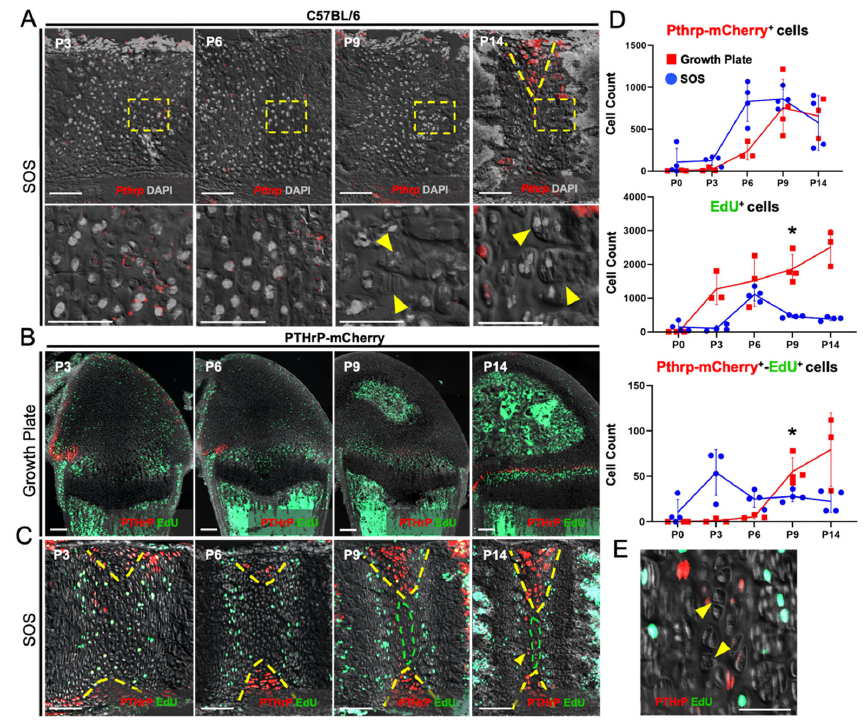
Figure 2. PTHrP expression is confined to the lateral wedge-shaped area of the synchondrosis. ( A , Upper panels) RNAScope in situ hybridization assays for endogenous Pthrp mRNAs in early postnatal development. ( A , Lower panels) 40 × magnified images of transition zones between resting, proliferating, and hypertrophic chondrocytes. ( B , C ) Pthrp-mCherry knock-in reporter activities and EdU-labeling in femoral growth plate ( B ) and spheno-occipital synchondrosis (SOS) ( C ). Red: Pthrp- Opal 570 ( A ), Pthrp-mCherry ( B , C ), gray: DAPI ( A ) DIC ( B , C ). Scale bars: 100 μ m. ( D ) Quantification of Pthrp-mCherry + (Upper), EdU + (Middle) and Pthrp-mCherry + -EdU + (Bottom) chondrocytes. n = 3/4 of each group/timepoint. * p < 0.05, one-way ANOVA followed by the Mann–Whitney U test. Data are present as the mean ± SD. ( E ) 40× magnification of central hypertrophic zone in P14 SOS. ( A , C ) Yellow dashed wedges: PTHrP-mCherry expression domain restricted to the lateral wedge- shaped areas, ( A , lower center panel) arrowheads: proliferating columns, ( A , lower right panel) arrowheads: hypertrophic chondrocytes, ( C ) green dashed lines: presumptive central hypertrophic zone, ( E ) arrowheads: presumptive central hypertrophic chondrocytes.